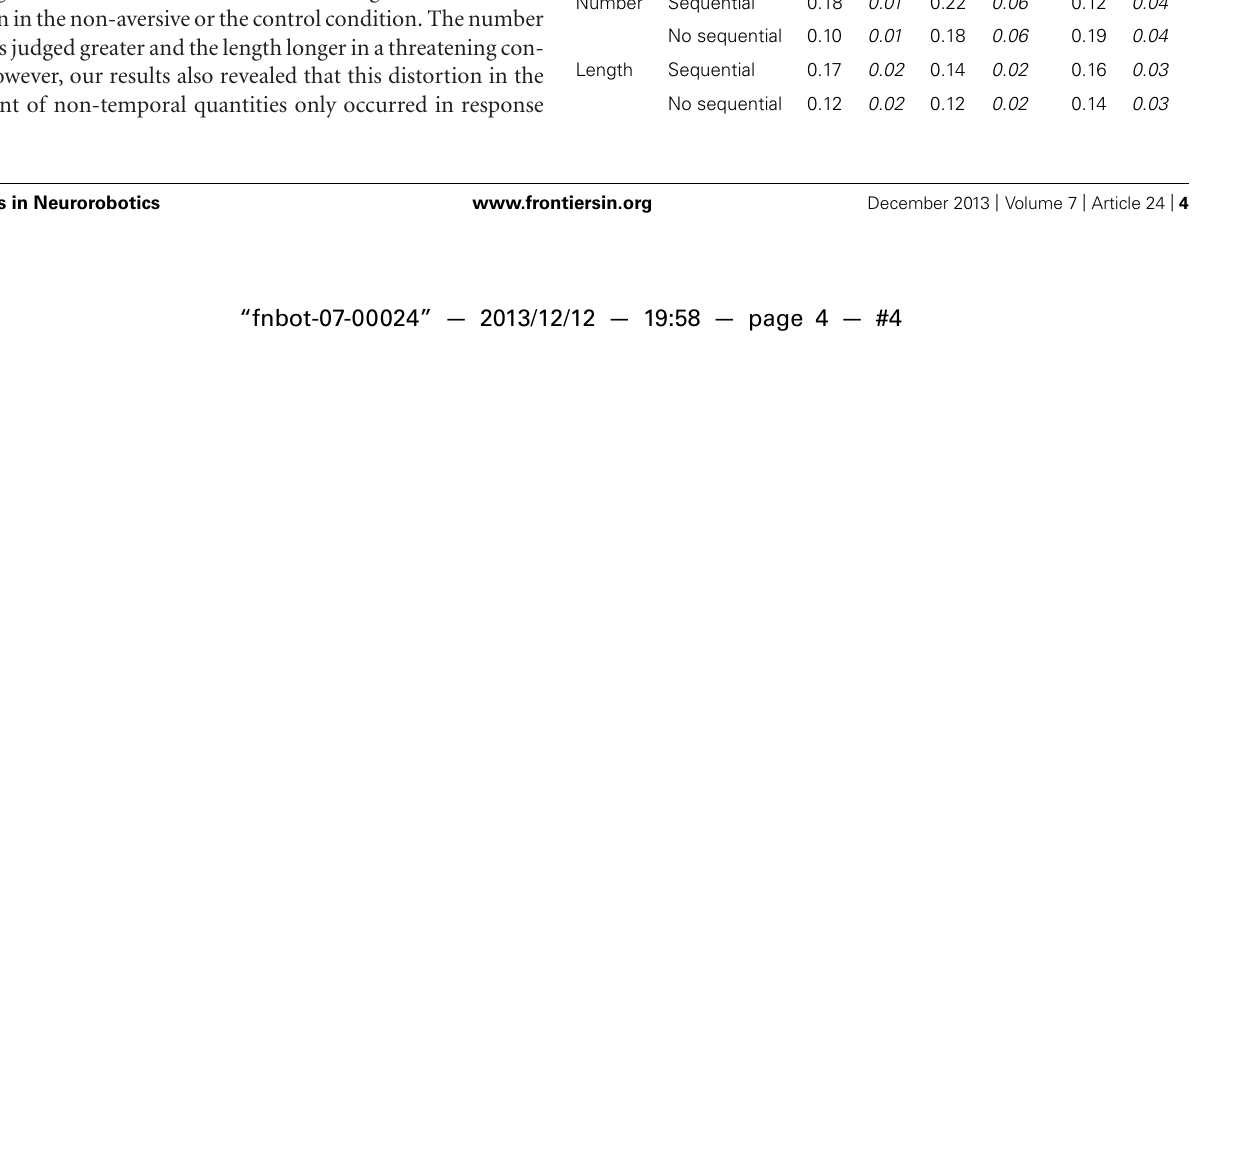
|S( p (many/long = 0.75 − |S( p (many/long) = 0.25|/ 2. However,